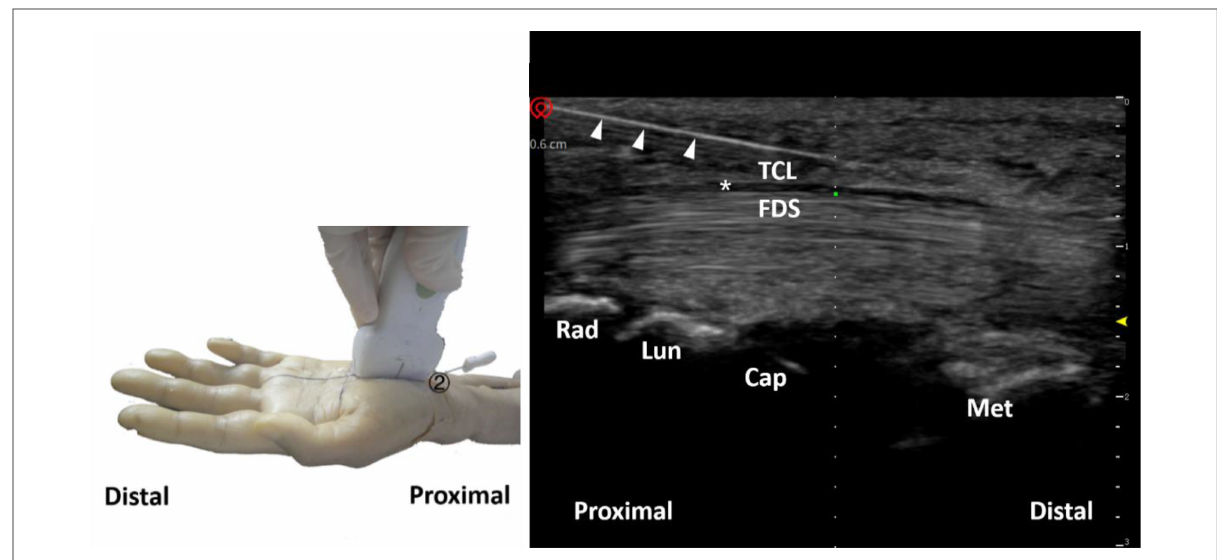
FIGURE 6 Schematic diagram of probe placement (left) and ultrasound-guided needle knife release diagram (right). The triangle refers to the needle knife position. The asterisk refers to the median nerve. ② , needle entry point 2; TCL, transverse carpal ligament; FDS, fl exor digitorum super fi cialis; Rad, radius; Lun, lunate bone; Cap, capitate bone; Met, metacarpal bone.